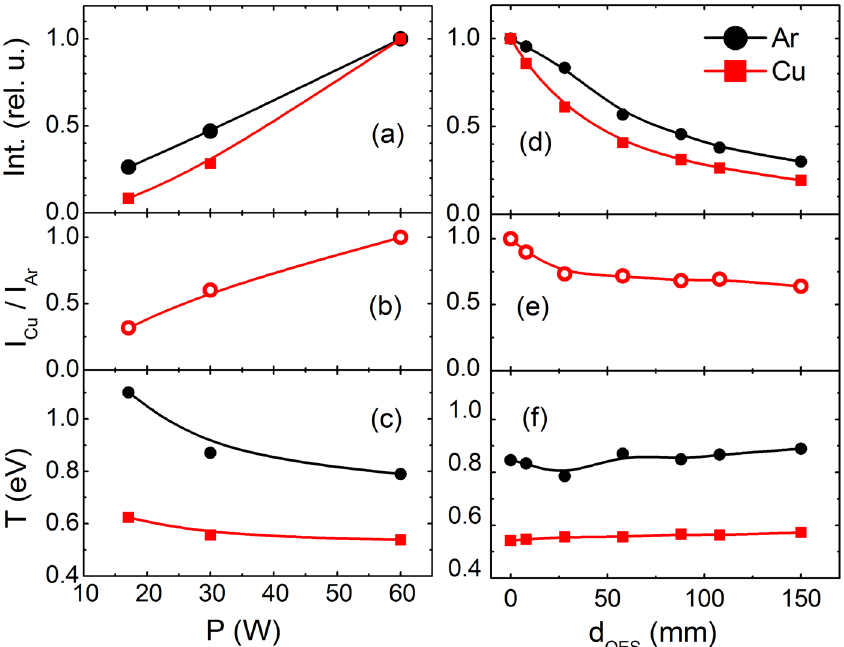
Figure 3. Comparison of the experimental Ar ( λ = 696.5 nm) and Cu ( λ = 578.2 nm) line intensities ( a,d ), the ratio between both intensities I Cu /I Ar ( b,e ) and the Ar and Cu excitation temperatures ( c,f ), depicted as a function of the magnetron power at a fix distance (d OES = 58 mm) ( a–c ), and as a function of the magnetron distance, d OES , at a constant power (P = 30 W) ( d–f ). Lines serve as